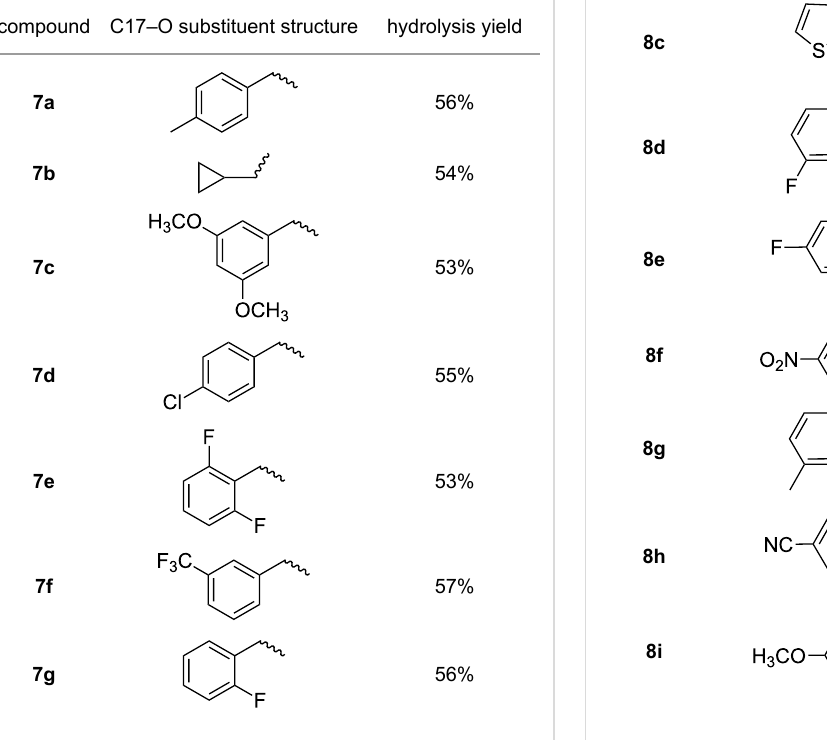
Table 1: The hydrolysis yields of spinetoram J analogues under weak acidic conditions.